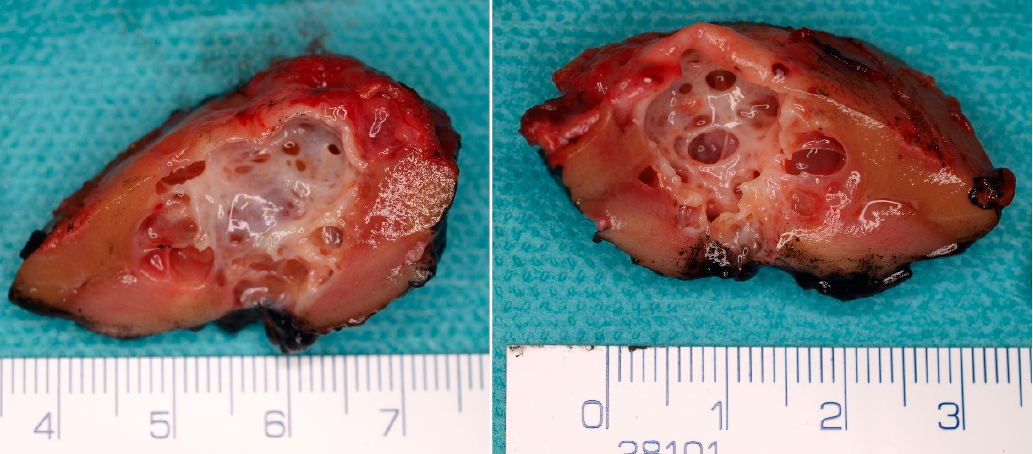
Figure 2. Macroscopic appearance of the MCRNLMP specimen from nephron sparing surgery. There is a multicystic lesion with a thin septa and variable sized cystic spaces without solid